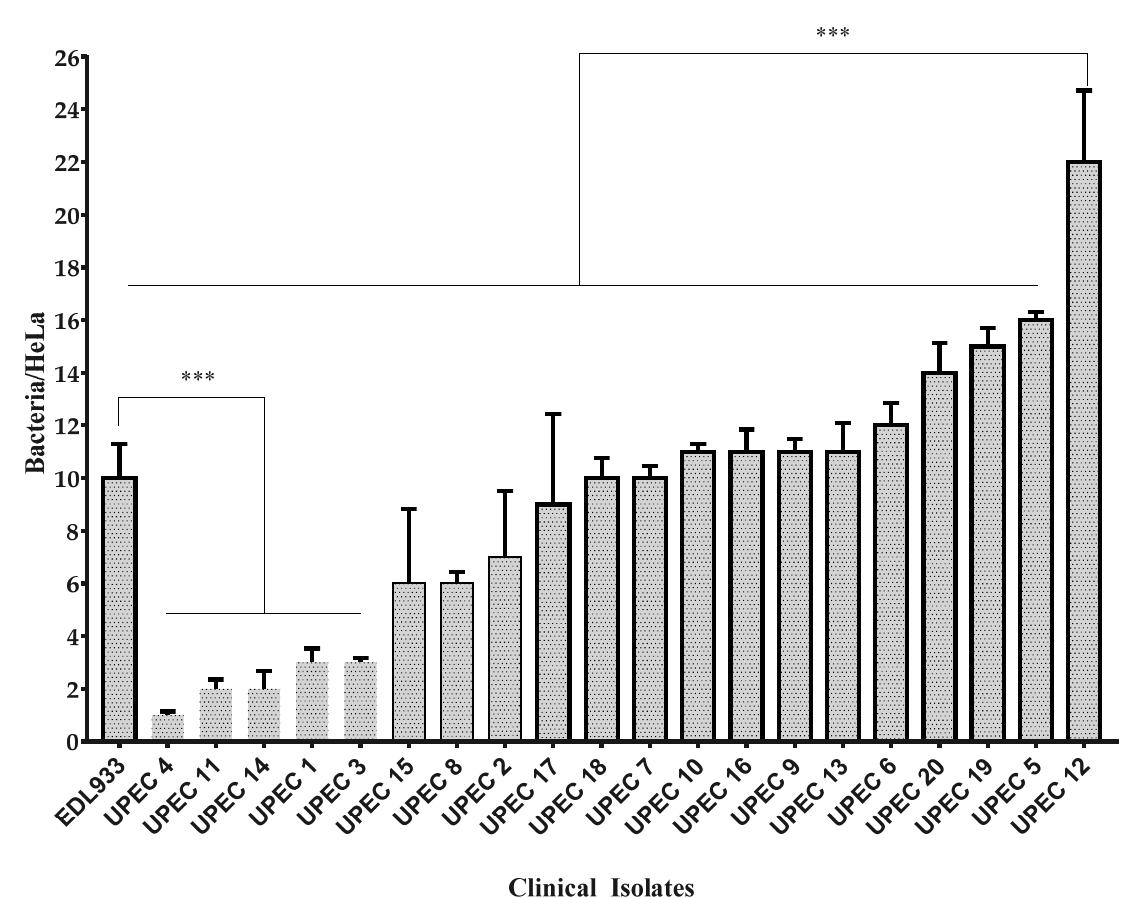
Figure 4. Adherence assay for UPEC clinical isolates. ***: p = 0.0001. One way ANOVA Tukey’s multiple comparisons test. Adherence groups are shown in the graph. Bars with thick line: strongly adherent group; bars with thin line: moderately adherent group; bars without line: low adherent group. Total HeLa cells and adherent bacteria were counted in 10 fields at 40X objective. The results are expressed as the average number of adherent bacteria from three independent experiments. Error bars show standard error of the mean (SEM).